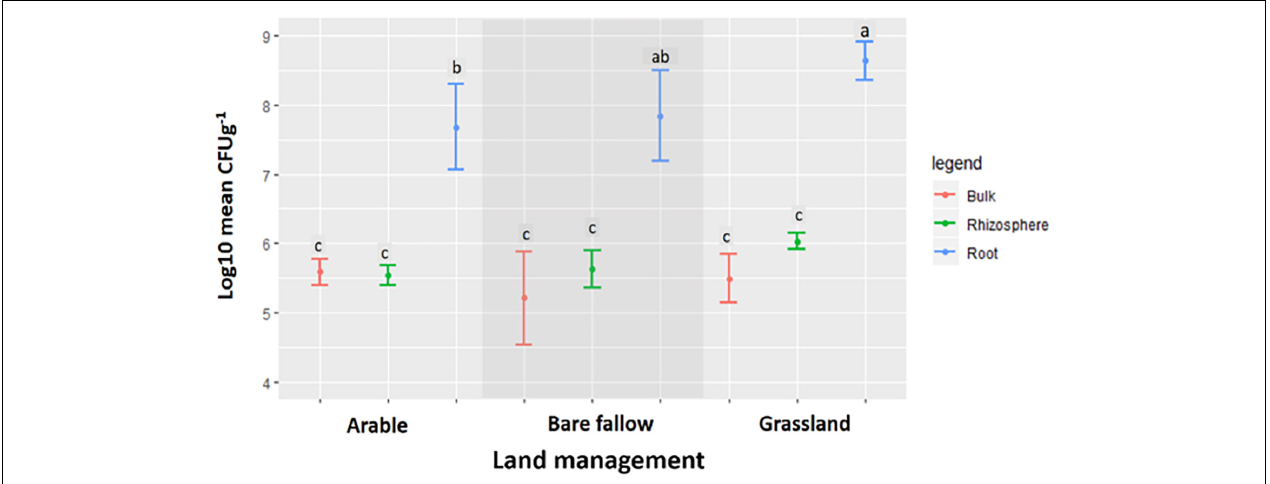
FIGURE 1 | The abundance of Pseudomonas spp. isolated from bulk soil, the rhizosphere, and roots of wheat grown in soils from three different land managements. Log transformed data for the mean CFU g − 1 ± SD of Pseudomonas spp. isolated from bulk soil, the rhizosphere, and the roots of wheat grown in soils from arable, grassland, and bare fallow managed soils. Symbols sharing the same letter are not significantly ( P < 0.05) different according to Tukey’s HSD post hoc test.